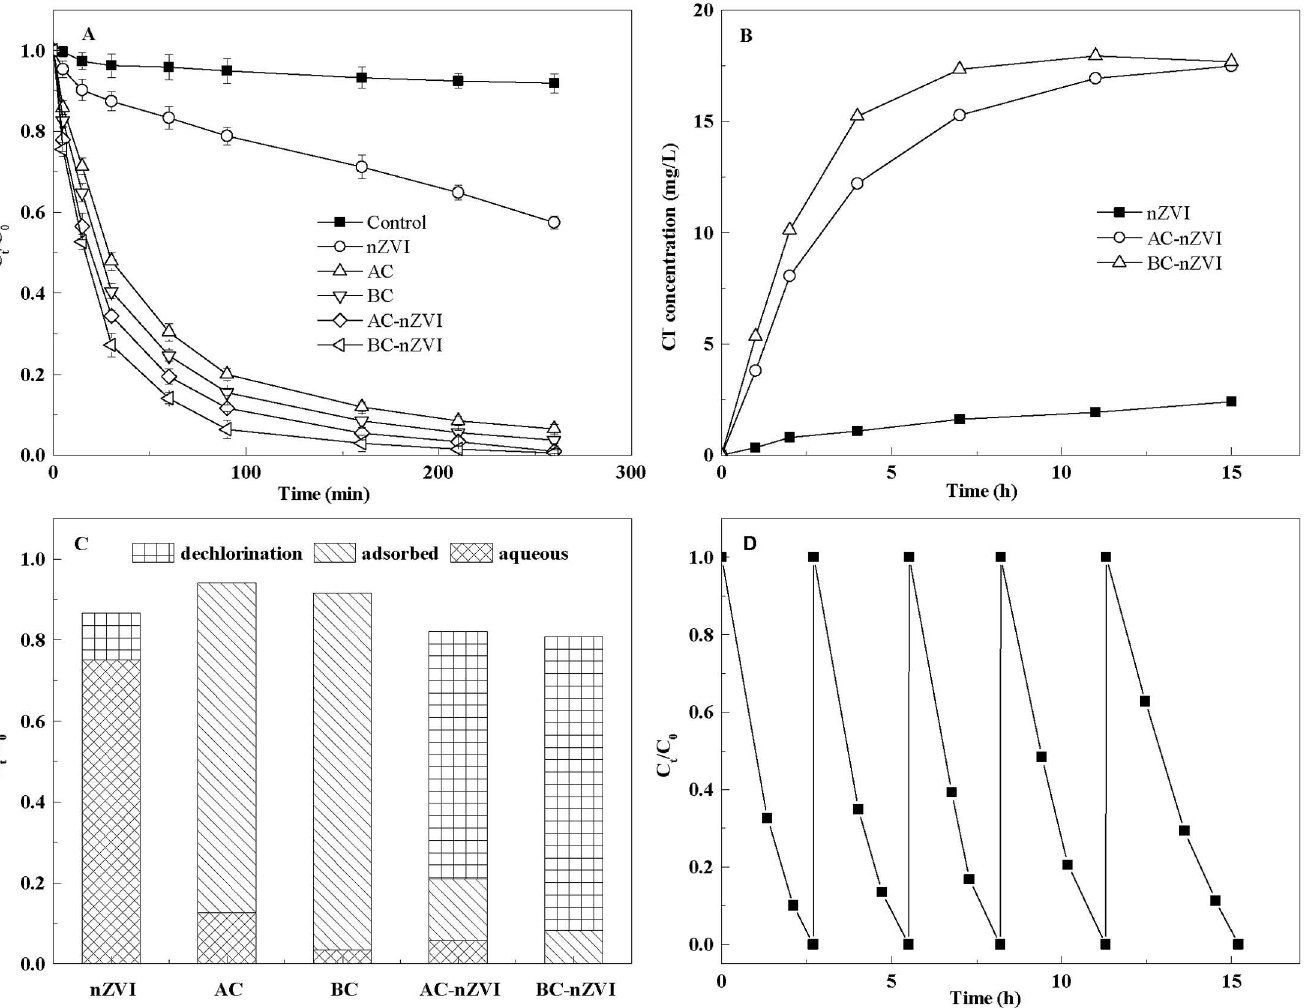
Fig 2. Removal of TCE by the BC-nZVI composite. A , TCE removal kinetics by BC-nZVI, AC-nZVI, nZVI, BC and AC; B , Changesin the Cl − concentration duringthe TCE removalprocess; C , TCE mass balancetaking into account sorbed, aqueous phaseand dechlorinatedTCE after 15 h; D , Removal of TCE by the BC-nZVI in the